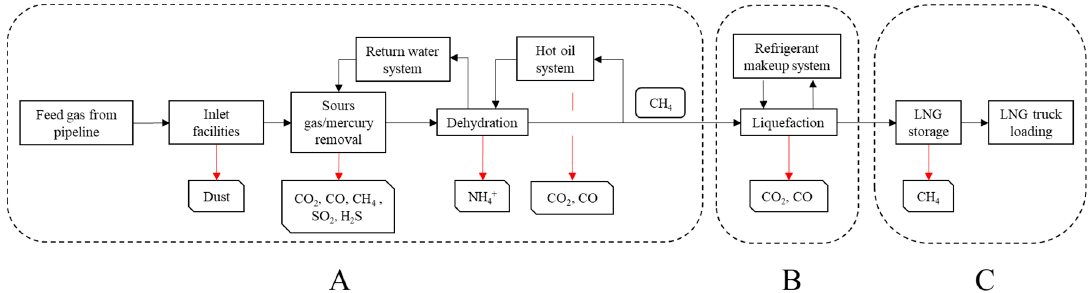
Figure 4. Emissions of pollutants from natural gas liquefaction plants throughout their life cycle. Phase A is pretreatment of feed gas, Phase B is liquefaction, and Phase C is storage and off-loading package.